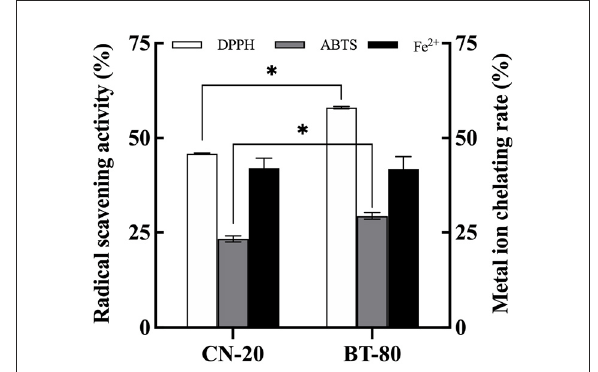
FIGURE1 Effects of soymilk production processes on the antioxidant properties of fermented soymilk. * indicates p < 0.05 according to Tukey’s HSD